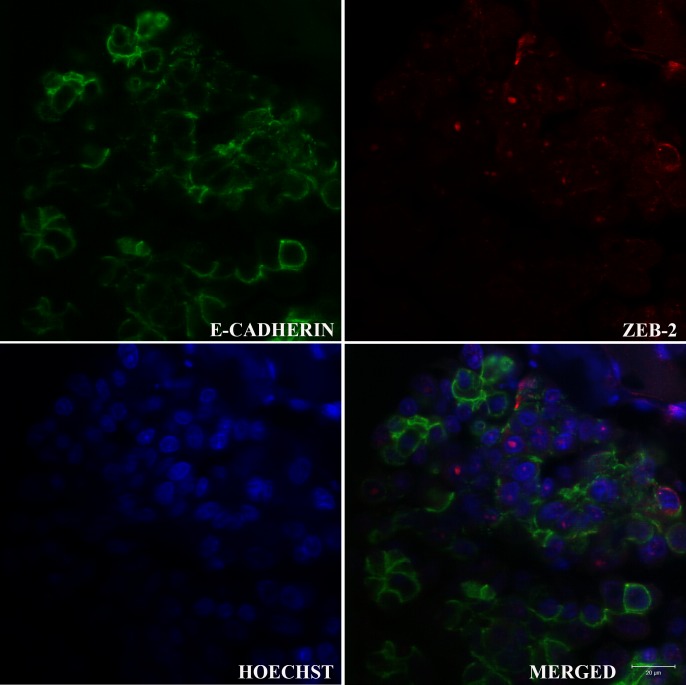
ZEB2 and E-cadherin expression in IMPC of the canine mammary gland.Confocal immunofluorescence image of the cytoplasmic membrane E-cadherin (green) (A), nuclear ZEB2 (red) (B) and nuclear staining with Hoechst (blue) (C). Note that most of the neoplastic cells present both, positivity for ZEB2 and negativity for E-cadherin. Some neoplastic cells reveal concomitantly positivity for ZEB2 and weak intensity E-cadherin expression. Nuclear localization of ZEB2 was confirmed for the merged image (D) that demonstrates the co-localisation of ZEB2 with Hoechst. Images are representative of what was observed in 10 fields of an IMPC case. Scale Bar = 20 μm.